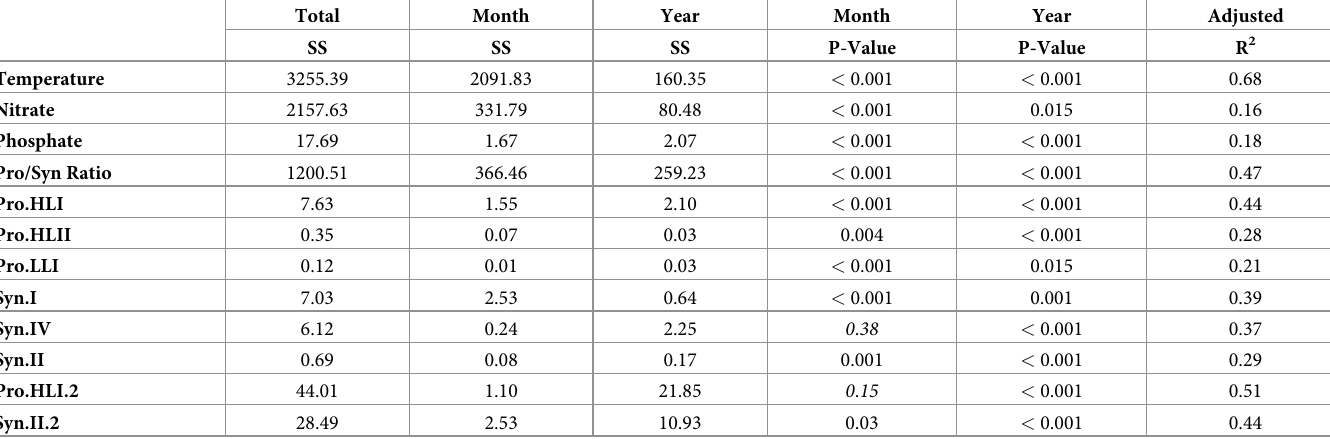
Table 1. Type II ANOVA results relating seasonality and interannual variability to environmental